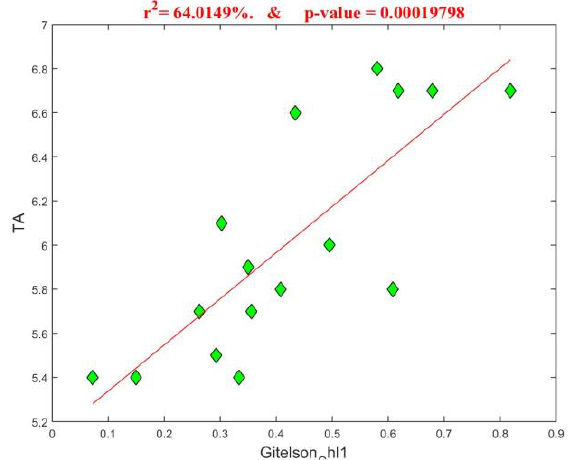
Figure 4. The highest correlation rate for the estimation of Brix- Figure 5. The highest correlation rate for the estimation of Total to-TA levels for the 2014 dataset was established with the Acidity levels for the 2014 dataset was established with the Gitelson_Chl1 index